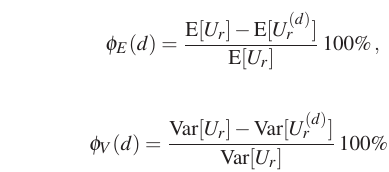
Figure 5: Variance of the queue content versus the load ρ (a) and the corresponding discretisation error (b) for different val- ues of d and for the asynchronous queue ( d = ∞ ) . defined as,